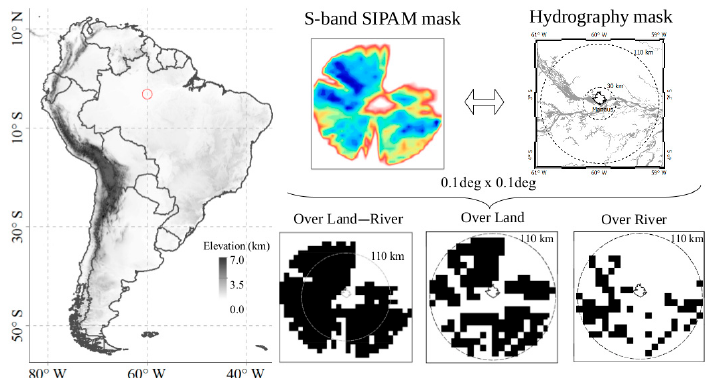
Figure 1. Study area; S-band Amazon Protection National System (SIPAM) radar location in Manaus (in red), Amazonas (AM); and surface class masks (land and river, land only, and river only).